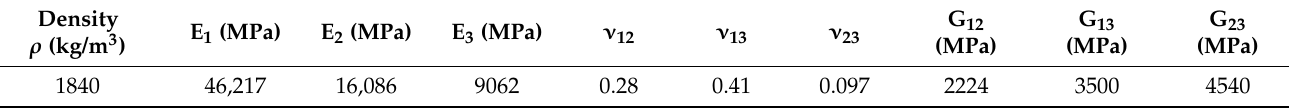
Table 2. Elastic properties of E-glass/epoxy composite.